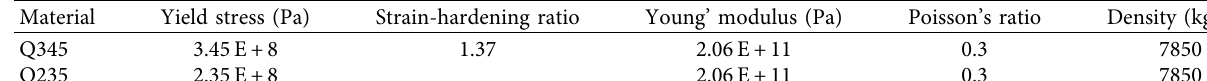
Table 3: Mechanical properties of Q345 and Q235.